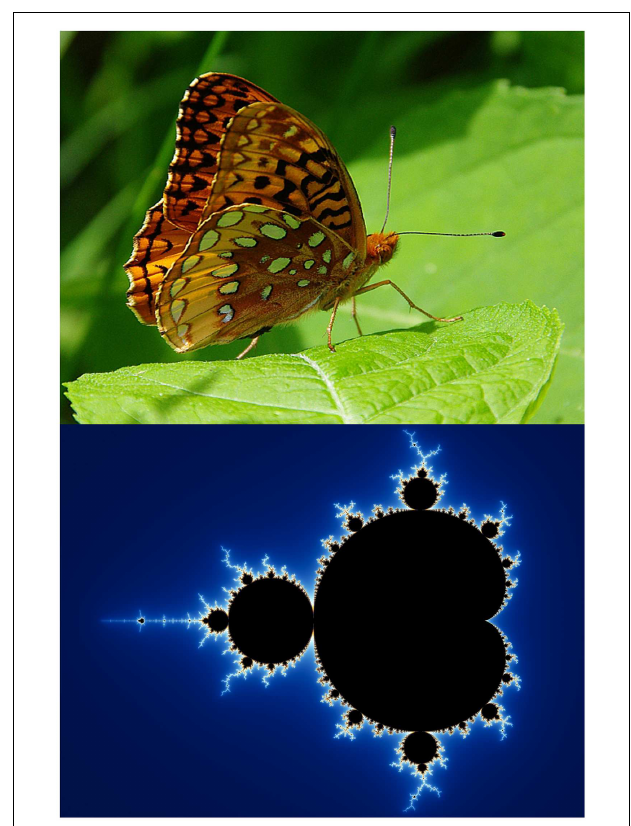
FIGURE 2 | Complexity as